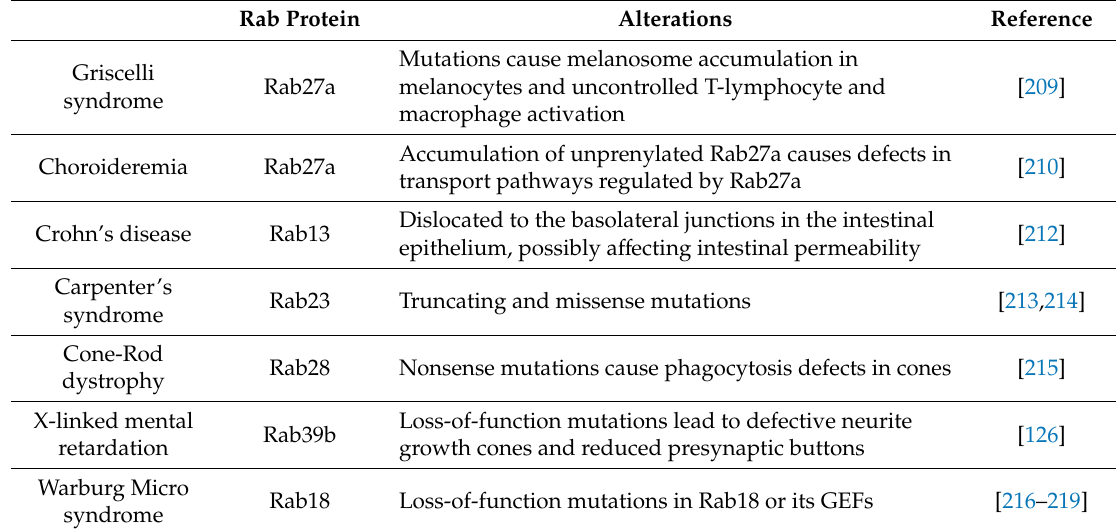
Table 4. Rabs implicated in immune disorders and other